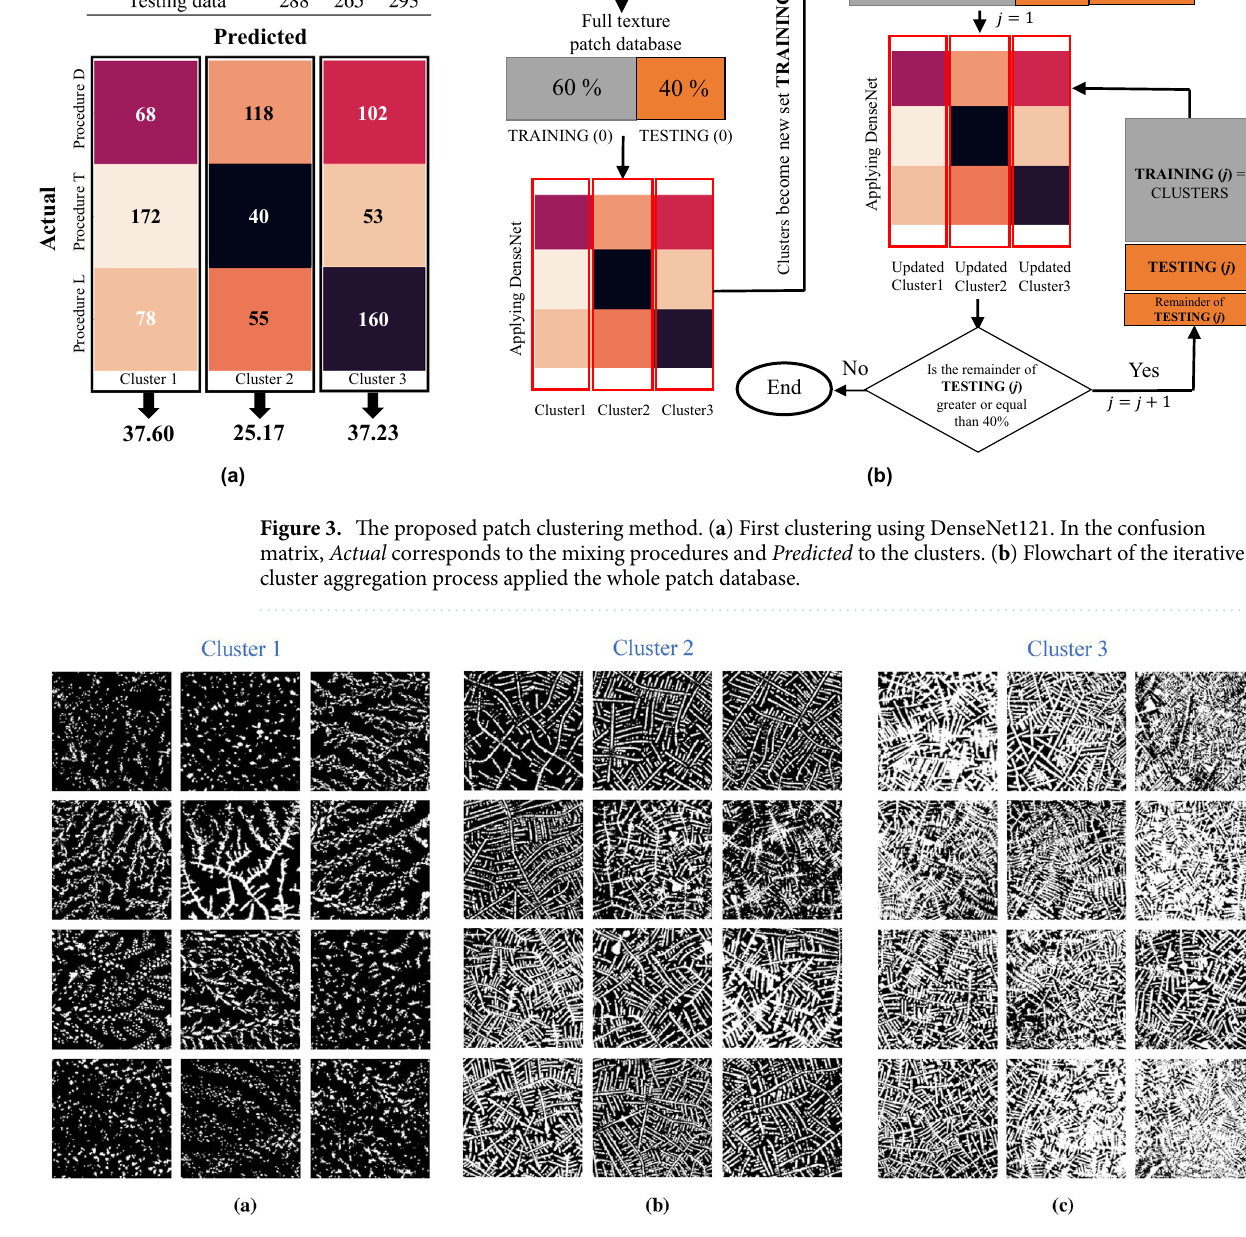
Figure 4. Examples of patches resulting after DenseNet based clusterization. ( a ) patches from cluster 1. ( b ) patches from cluster 2. ( c ) patches from cluster